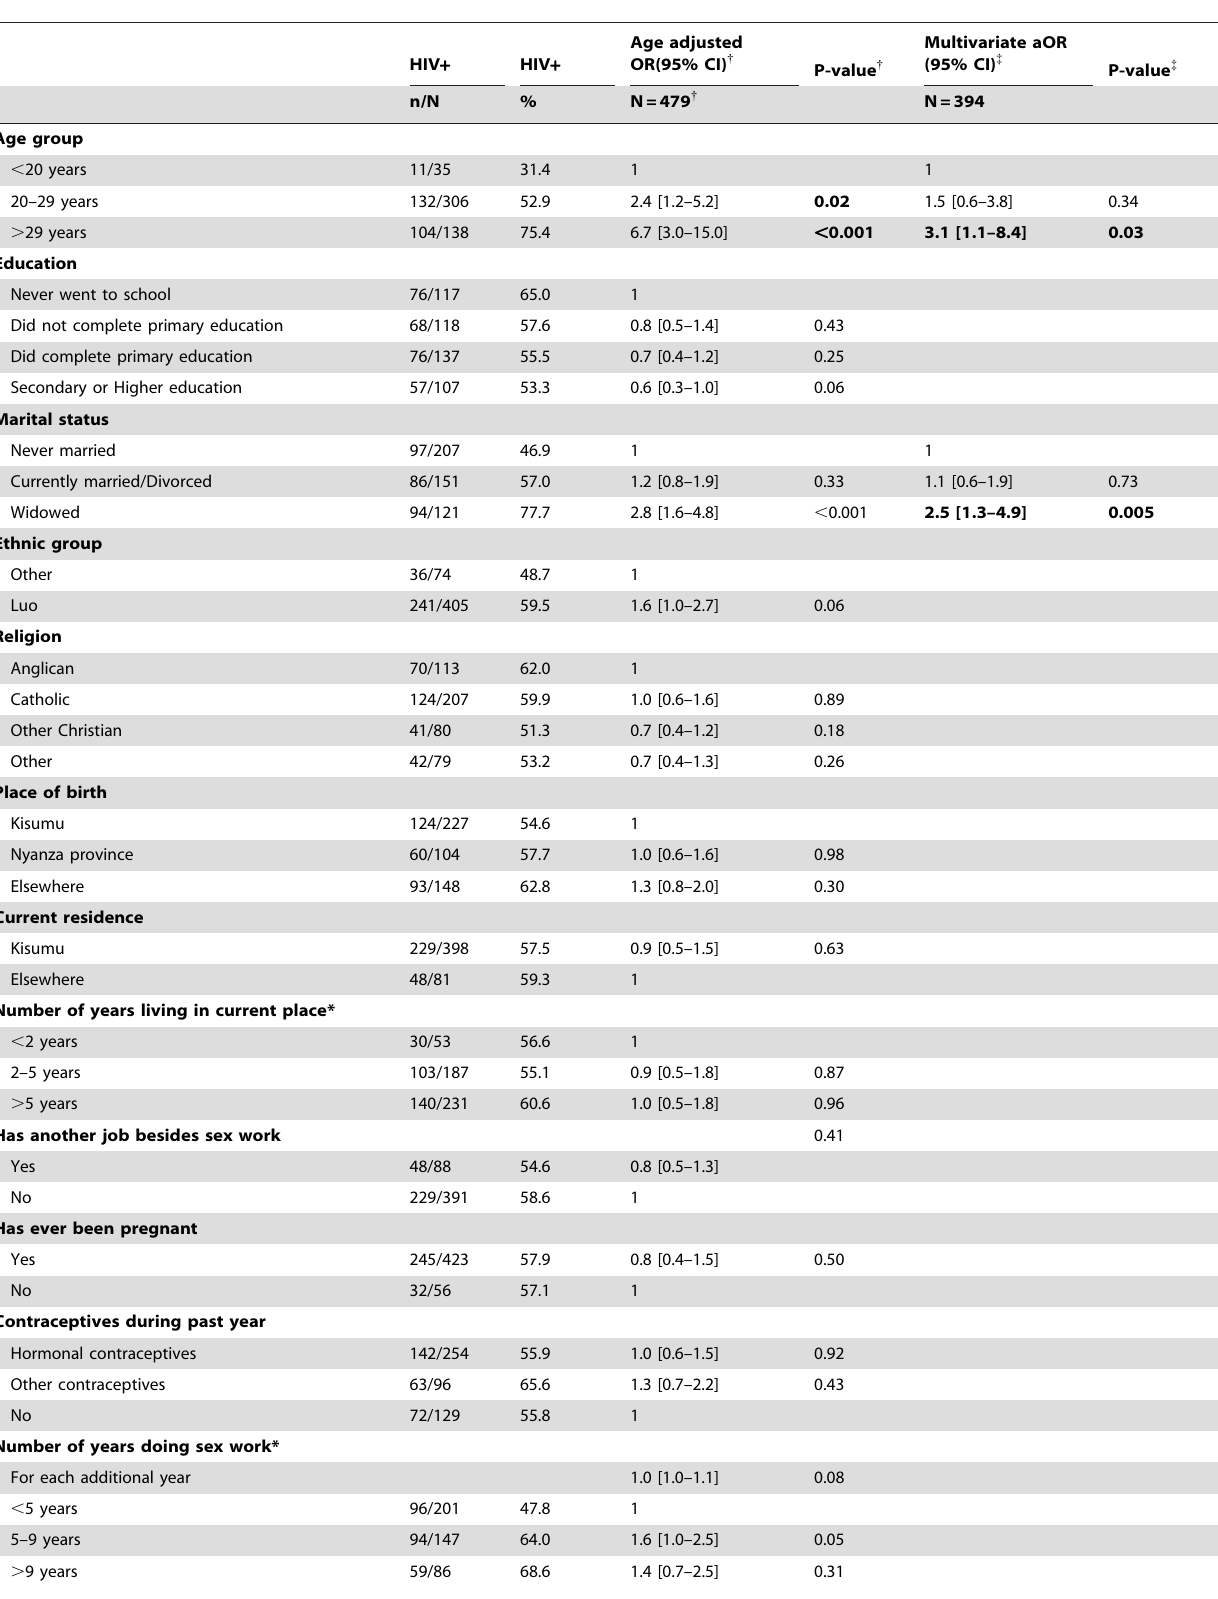
Table 3. Factors associated with HIV in the 2008 survey (N= 479): Age group adjusted and multivariate